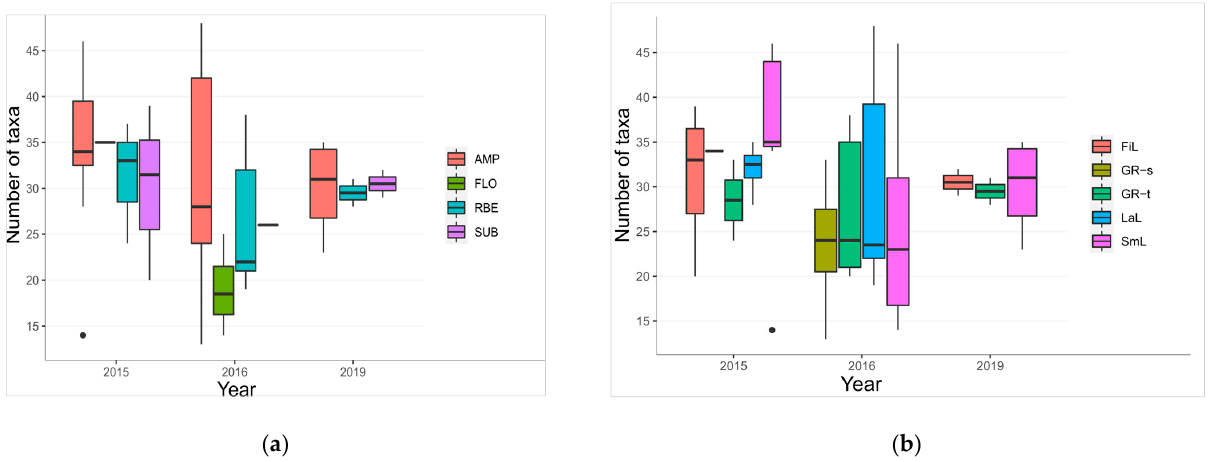
Figure 15. Comparison of species richness of diatoms in the macrophyte samples from the Dehtá ř fishpond classified into species groups. Years 2015, 2016, and 2019: ( a ) Functional groups based on the ecology and life-history traits of macrophytes; ( b ) functional groups based on leaf morphology. Median values (horizontal lines), lower and upper quartiles (boxes, i.e., 50% of the observed values), 5% and 95% percentiles (whiskers, i.e., 90% of the observed values), and outliers (points, i.e., the values outside the 90% range) are displayed. Abbreviations: AMP—amphibious species, FLO—floating-leaved aquatics (both free-floating and rooted); RBE—reed bed species; SUB—submerged aquatics; FiL—filamentous leaves; Gr-s—grasslike small; Gr-t—grasslike tall; LaL—large leaves; SmL—small leaves. For the classification of particular macrophyte species into functional groups, see Table S3.